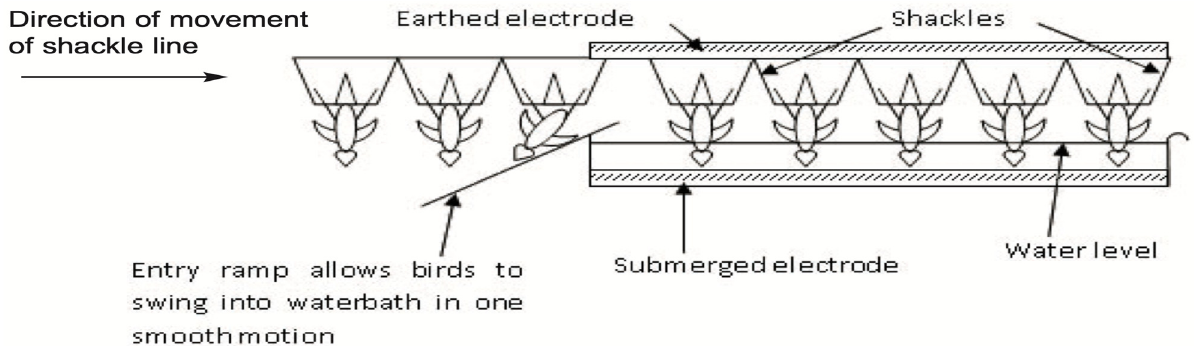
Figure 2. Prevention of pre-stun shocks with an entrance ramp which ensures that birds enter the water bath in a single smooth movement to be stunned immediately (image credit: Humane Slaughter Association (HSA). Reproduced with permission from the HSA from: Electrical Waterbath Stunning of Poultry, HSA 2016 [35]).